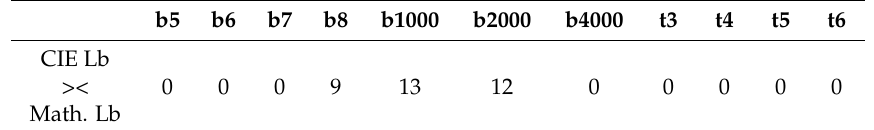
Table 7. Significant difference scores (%) between the two background luminance definitions (lab. study).